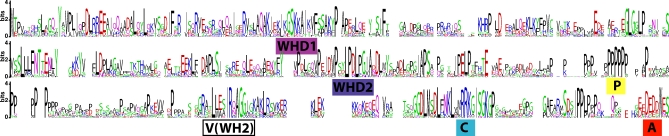
LogoPlot of Protein Alignment of WASH Orthologs from 21 Diverse Species from Mammals to Entamoeba
Heights of letters indicate degree of conservation in units of maximum entropy expressed in bits. Colors indicate amino-acid similarity: KRH, green; DE, blue; and AVLIPWFM, red. Conserved domains discussed in the text are labeled at their approximate midpoints. Gaps indicate regions in the alignment where only a minority of the sequences has residues present. The actual alignment is provided in Figure S4.